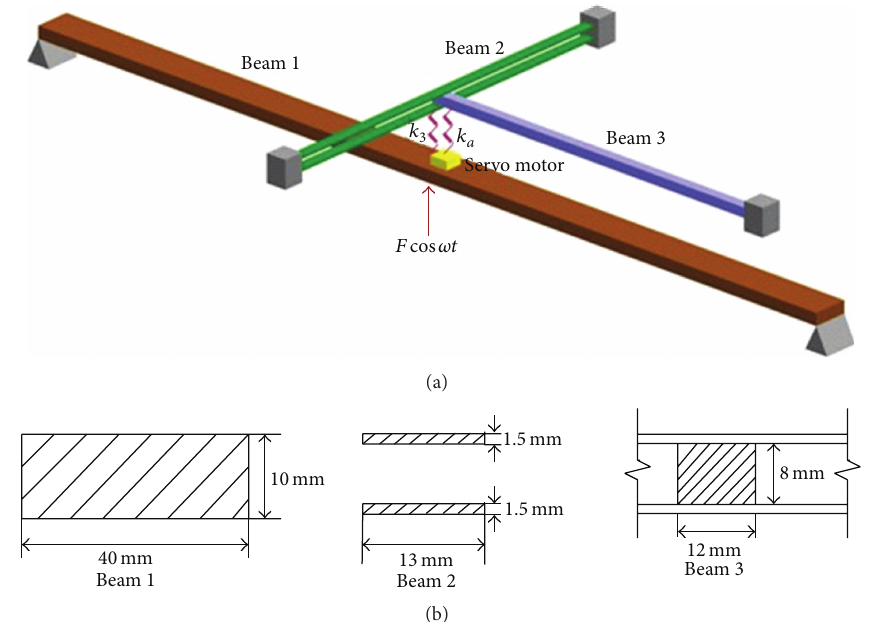
Figure 1: The schematic diagram of the structure: (a) the scheme of structure; (b) the section size of each